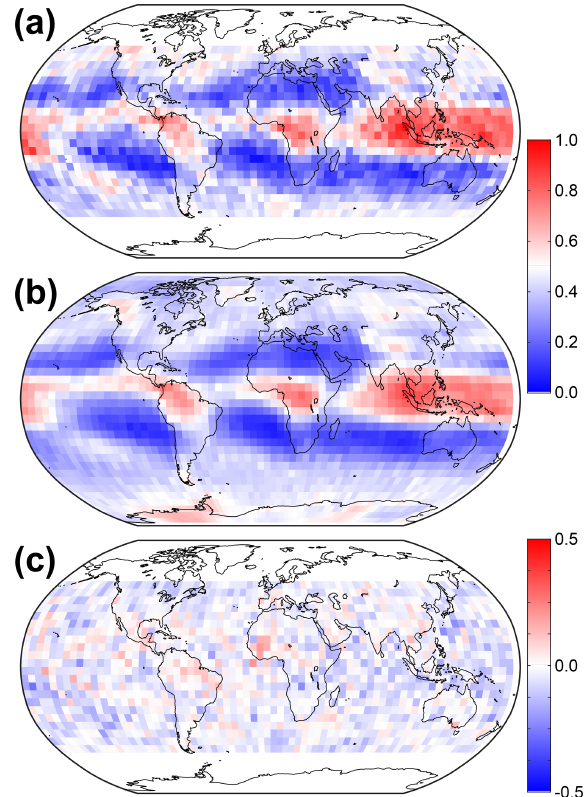
Figure A1. Global distribution of the fraction of cirrus clouds in observations with the (a) CATS and (b) CALIPSO lidars and (c) difference between CALIPSO and CATS for the time period from March 2015 to October 2017. Only CATS data within ± 1h around the fixed CALIPSO overpass times are